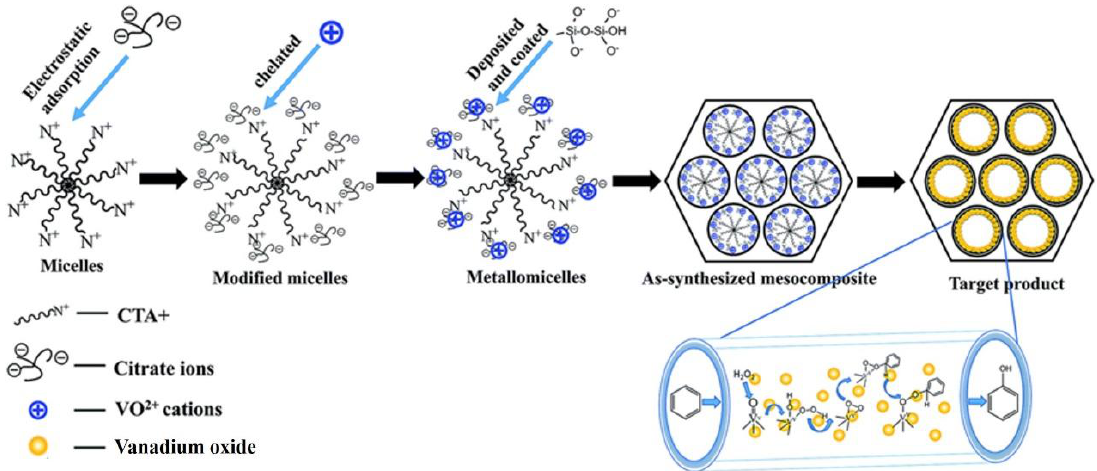
Figure 5. Schematic mechanism for material self-assembly. Reproduced from Ref. [67], Copyright 2015, with permission of The Royal Society of Chemistry.